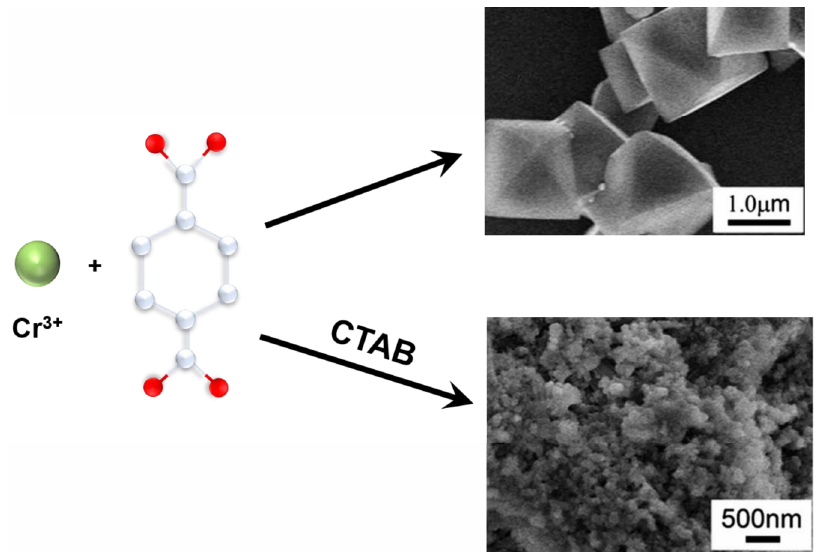
Figure 6. Synthesis of HP-MIL-101(Cr) by template method [43]. Adapted with permission from ref. [43]. Copyright © 2022, Royal Society of